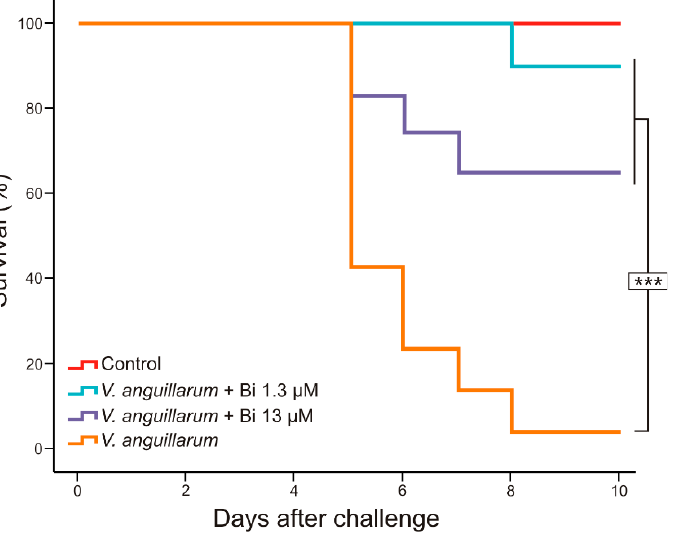
Figure 3. Survival rates of fish experimentally infected with Vibrio anguillarum RV22 and treated with 1.3 and 13 µM of Bi(III)-deferiprone. Asterisks (***) denote statistically significant differences ( P < 0.001).